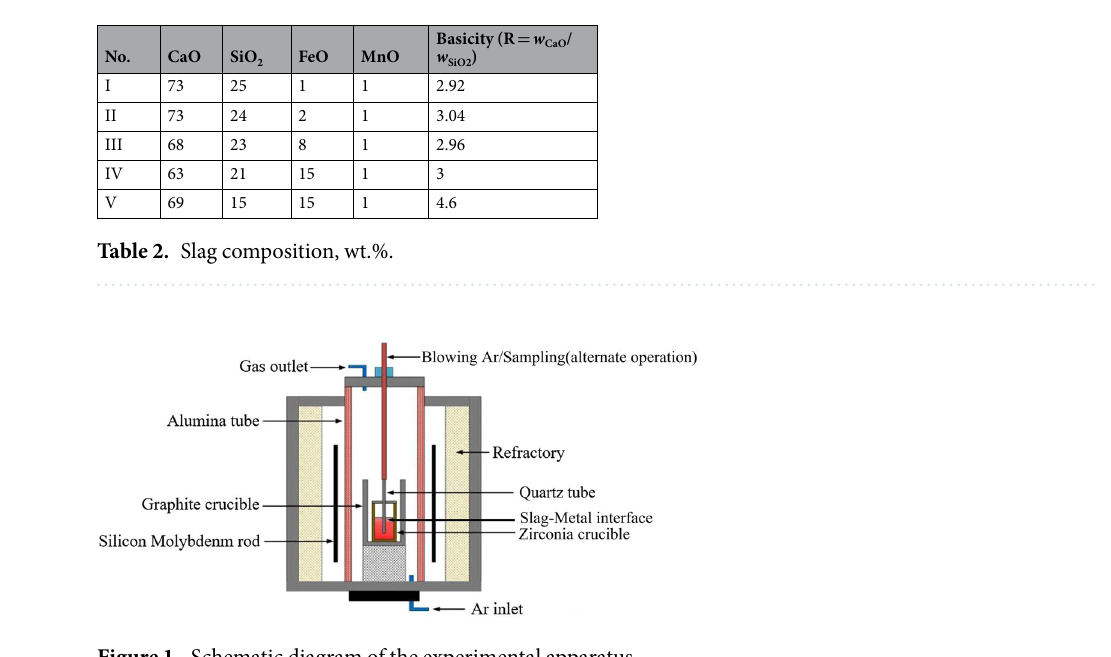
Figure 1. Schematic diagram of the experimental